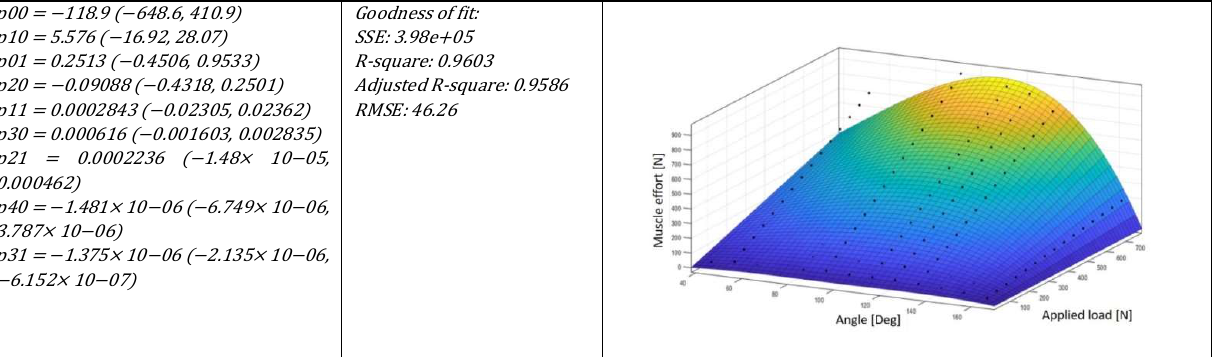
Figure 19. General formulation of the medium triceps efforts based on wrist load (W) and elbow angle ( α ) and surface reconstruction of the proposed polynomial. angle ( α ) and surface reconstruction of the proposed